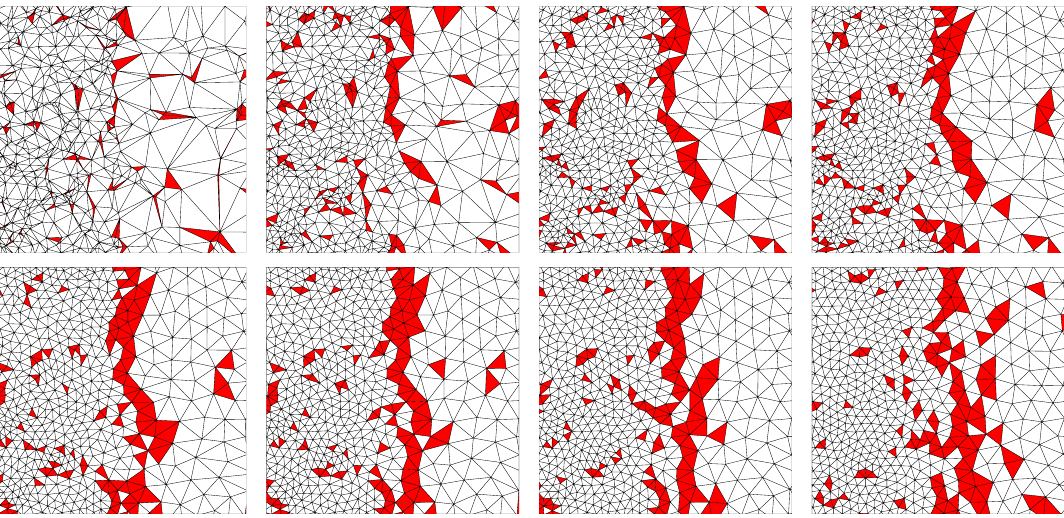
Figure 9 . The same as the right panel in figure 7, but showing the effect of applying the Lloyd algorithm with varying number of steps as in figure